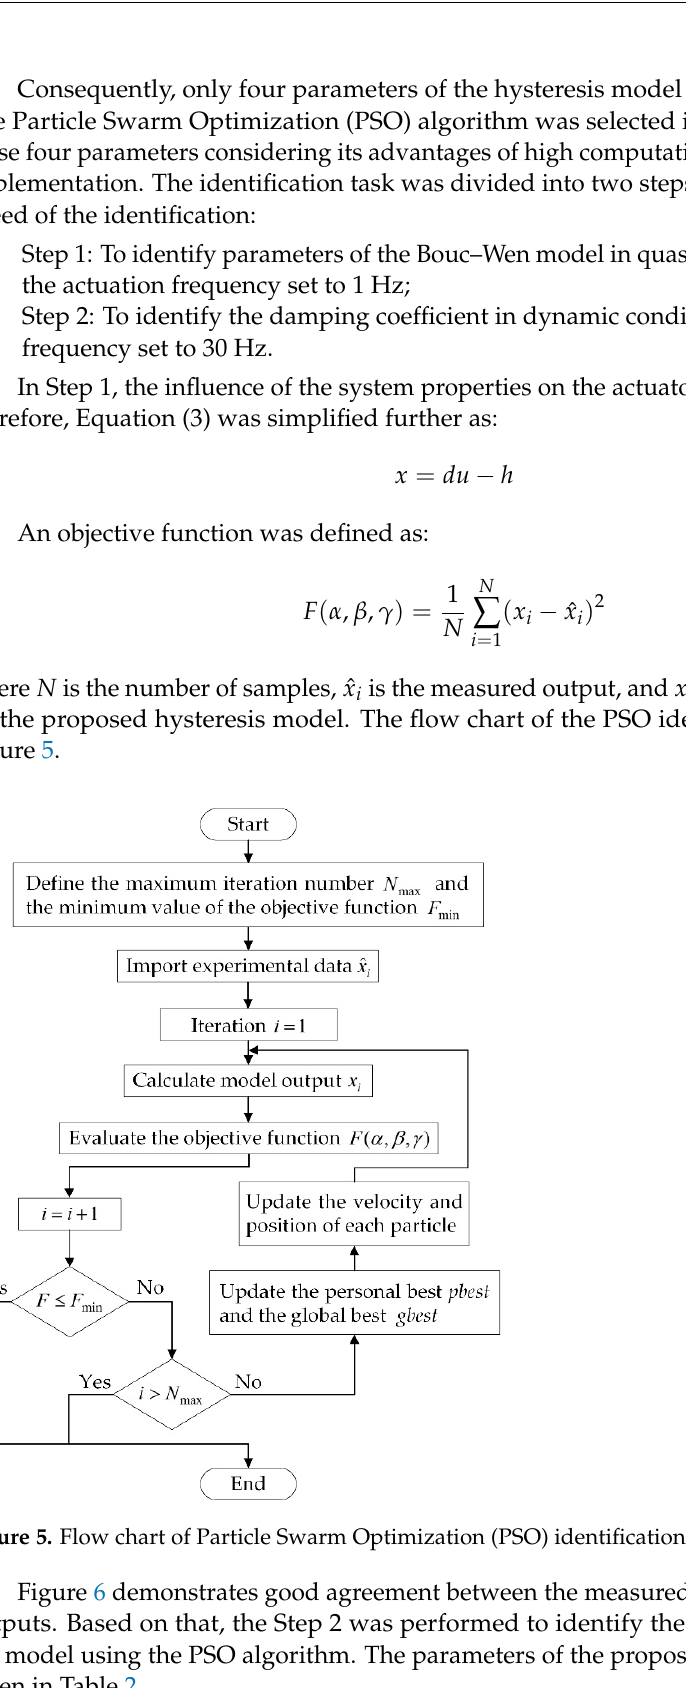
Figure 6. Comparison between the measured outputs and the model outputs at 1 Hz. Table 2. Parameters of the hysteresis model. Parameter